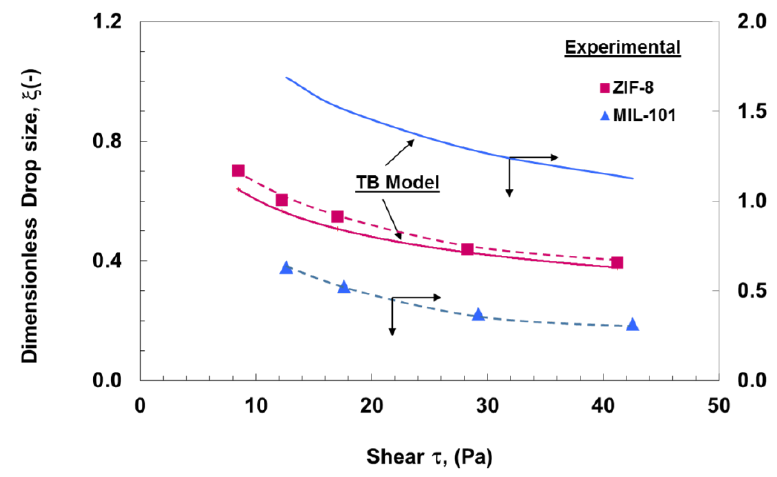
Figure 9. Comparison between measured droplet size (broken lines with markers) and torque balance (TB) model prediction (solid lines) for emulsions stabilized using MOF particles.